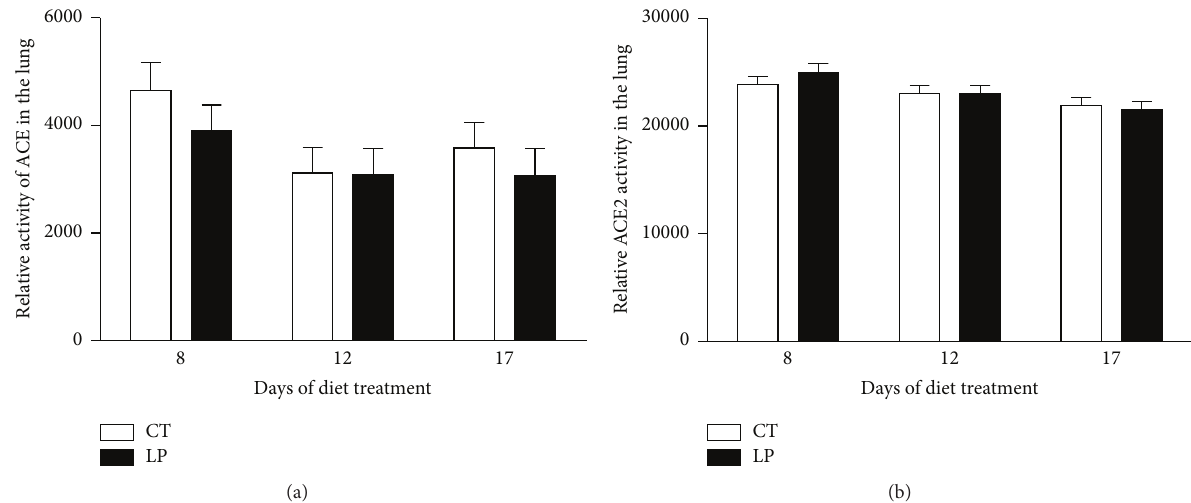
Figure 3: Relative activities of ACE and ACE2 in the lung of nonpregnant rats fed a low-protein diet. CT: control; LP: low protein. The error bar represents the mean ± SEM ( 𝑛 = 6 rats/diet group/day).